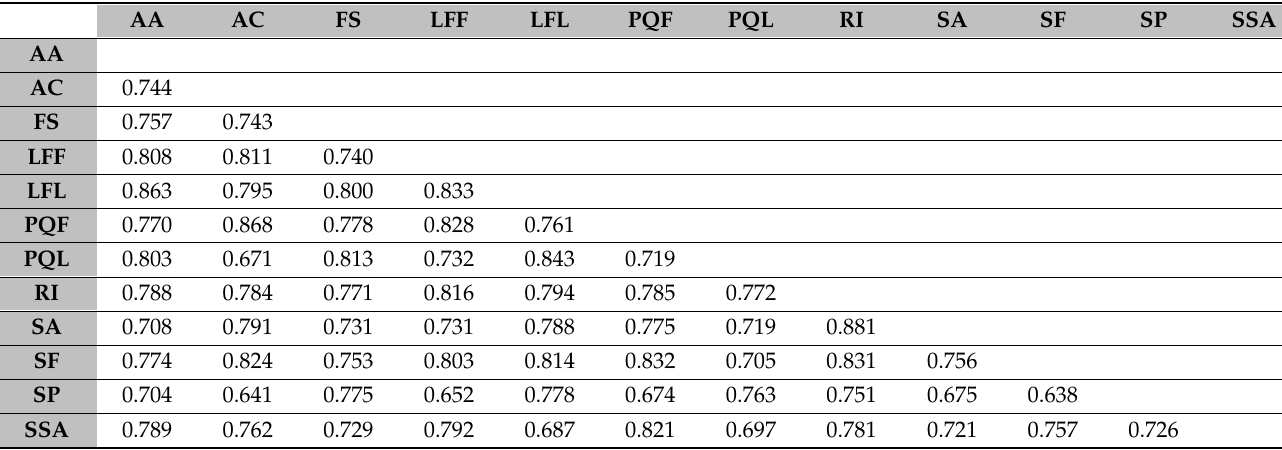
Table 4. HTMT Discriminant Validity Test Result.